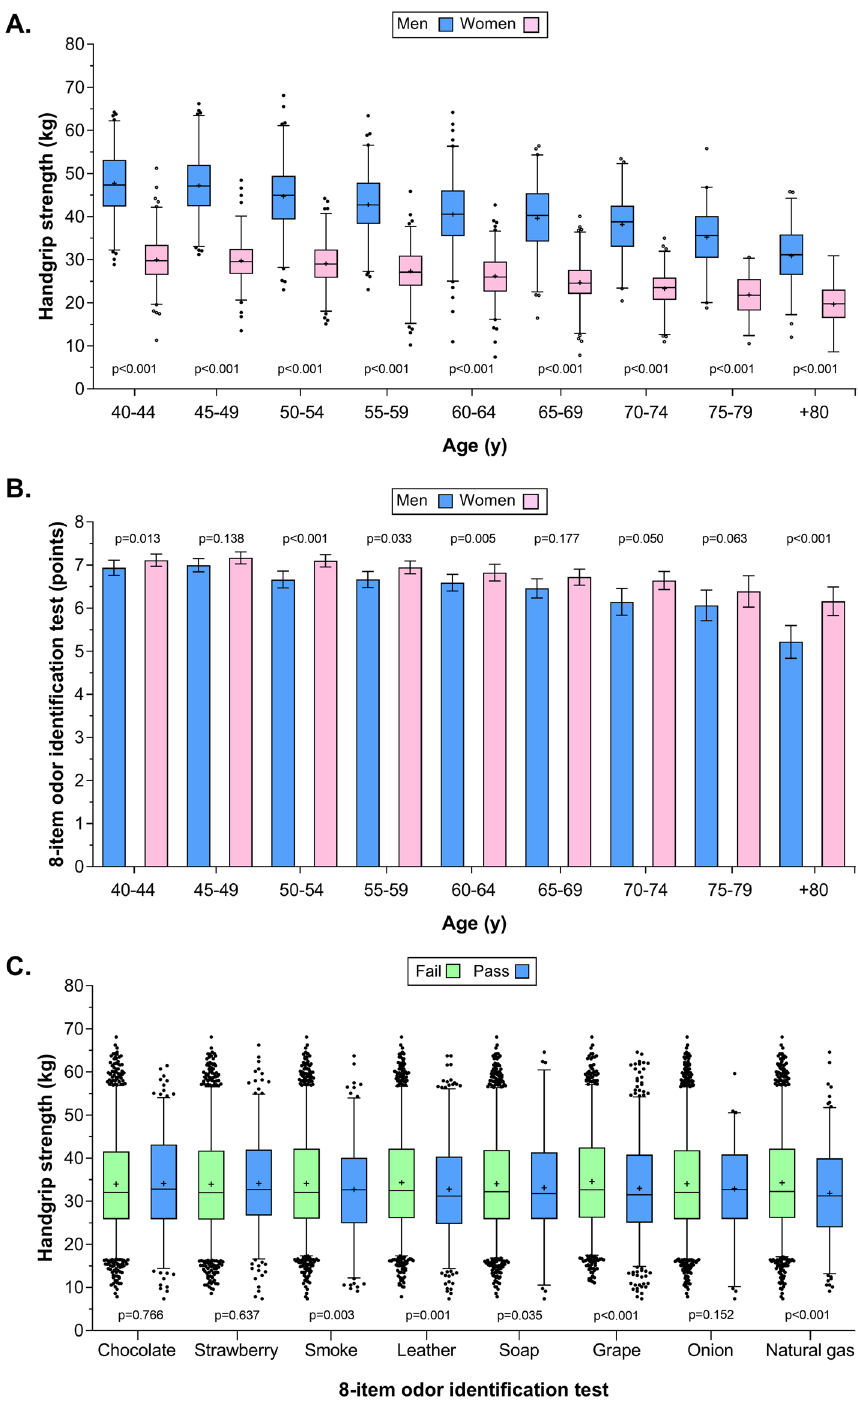
Figure 1. Absolute handgrip strength and odor identification results. ( A ) Differences between mean absolute handgrip strength by sex and age group. ( B ) Differences between mean absolute handgrip strength and result of the 8-item odor identification test. ( C ) Differences between mean absolute handgrip strength and result of the 8- item odor identification test (test fail or pass). In the box and whiskers, the + indicates the average value. The error band indicates the 2.5–97.5 percentile for each value. Outliers are plotted as individual